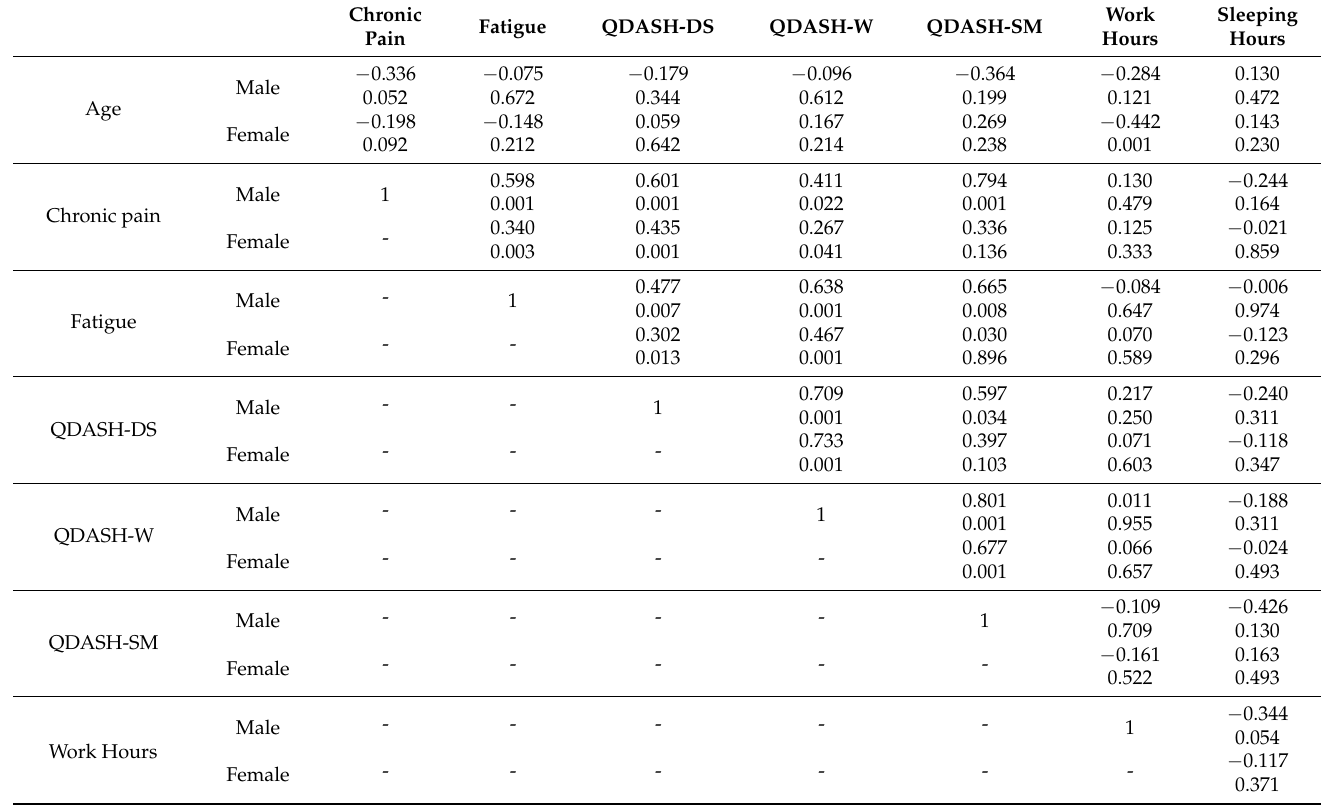
Table 5. Coefficients of correlation between chronic pain, fatigue, QuickDASH, working hours, and sleeping hours in males and females. Spearman’s rank correlation coefficient (upper) and p -value (lower) between the chronic pain, fatigue and QuickDASH characteristics for males and females.